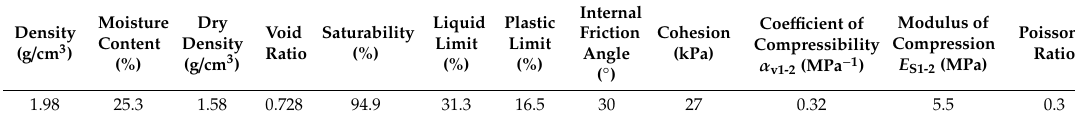
Table 1. Physical and mechanical parameters of the tested soil.